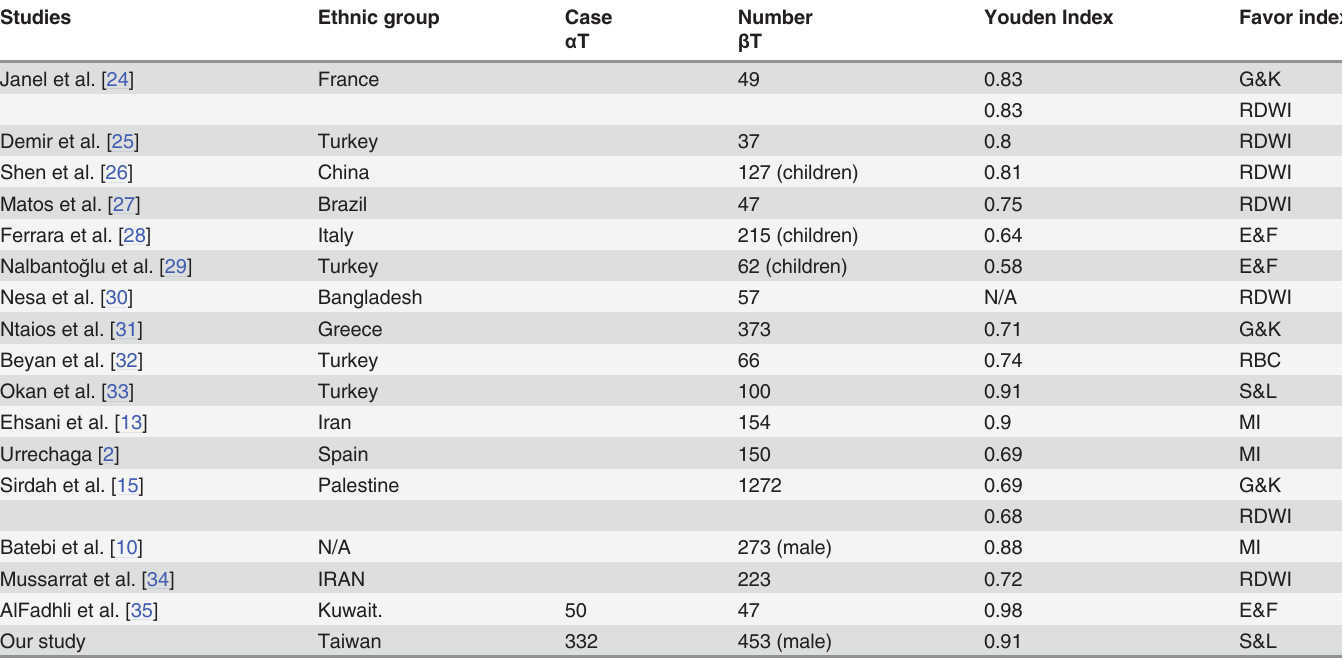
Table 6. summarizes different study results that focused on the RBC discrimination index in thalassemia patients and normal individuals of different ages and genders in various